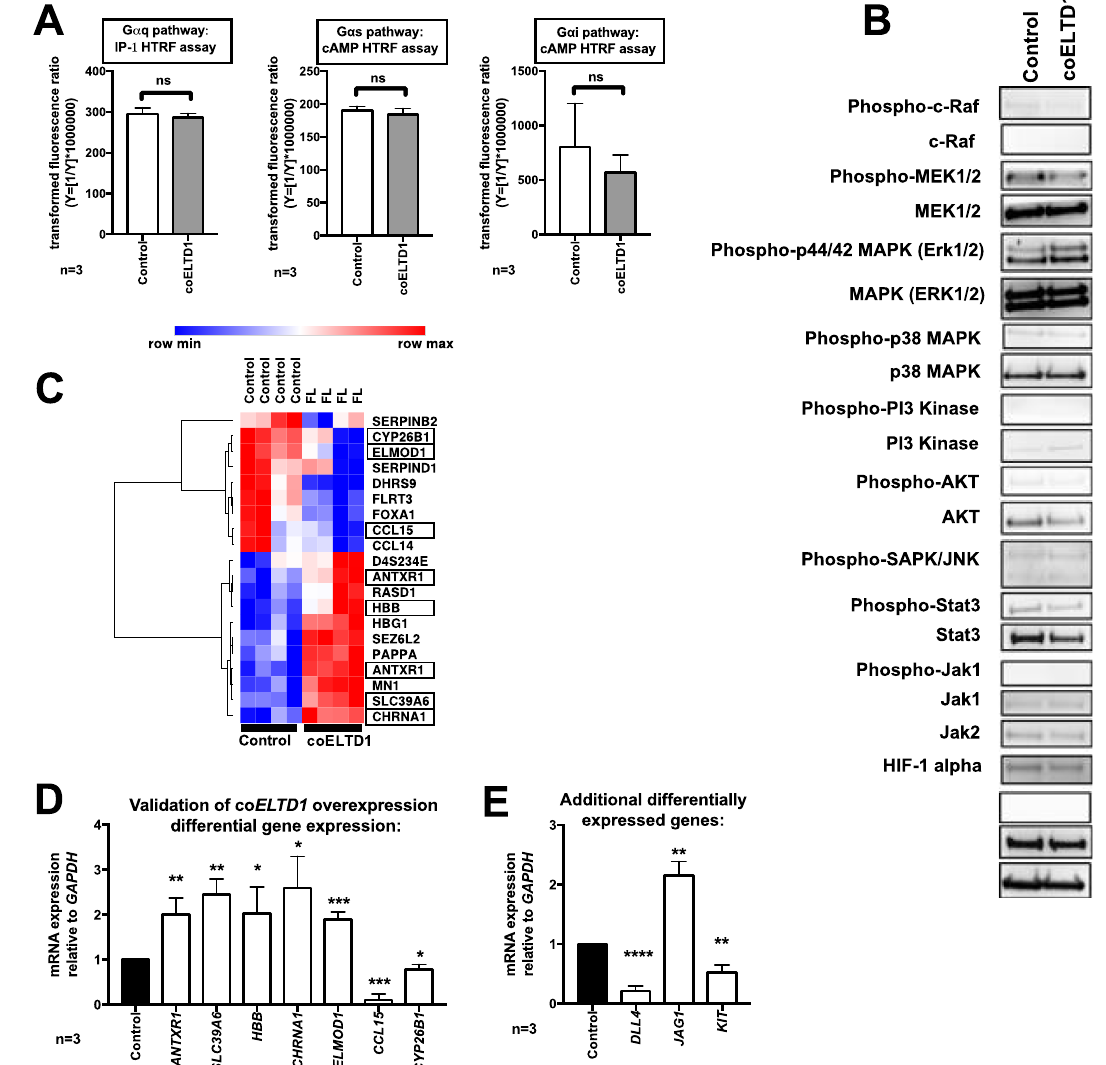
Figure 4. ADGRL4/ELTD1 overexpression in HUVECS does not induce canonical GPCR or MAPK/ERK, PI3K/AKT JNK, JAK/HIF-1α, Beta-catenin and STAT3 signalling. ( A ) Gαq, Gαs, Gαi HTRF FRET assays in ADGRL4/ELTD1 overexpressing HUVECs showed no signalling. ( B ) Western blot showed no change in a range of non-GPCR signalling pathways: MAPK/ERK, PI3K/AKT JNK, JAK/HIF-1α, Beta-catenin and STAT3 pathways. ( C ) Heatmap depicting significant differentially expressed genes following transcriptional profiling in FL ADGRL4/ELTD1 stable overexpressing HUVEC cells compared to control HUVECS. The intensity colouring (low = blue; high = red) represents the z-score for each gene. Boxes represent validated genes. ( D ) qPCR validation showed ANTXR1 , SLC39A6 , HBB , CHRNA , ELMOD1 upregulation, and CCL15 and CYP26B1 downregulation. ( E ) qPCR of additional genes showed DLL4 and KIT downregulation and JAG1 upregulation. (Abbreviations: co = codon optimised; FL = full